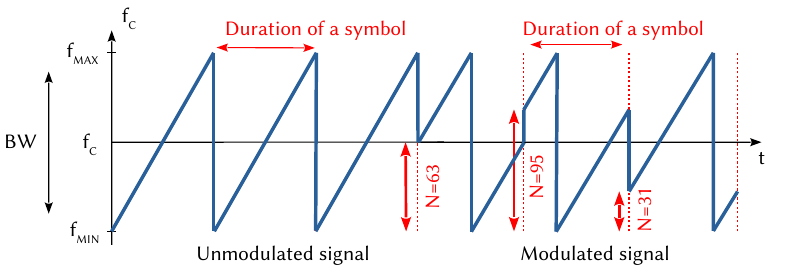
Figure 4. LoRa CSS modulation.